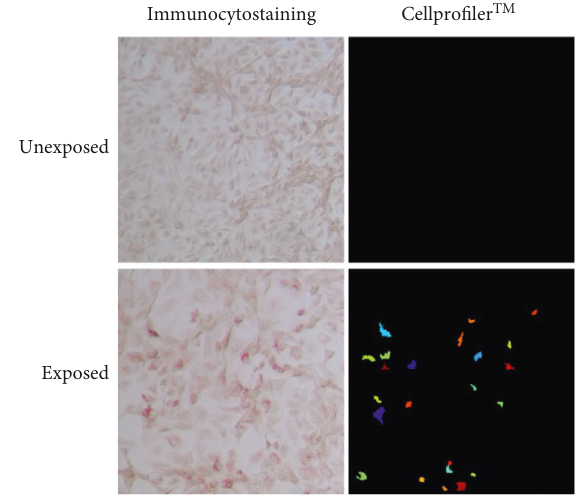
Figure 6: FFAs of natural DENV infection. 10x magnification factor. The plasma was diluted 4 times. The different foci detected automatically by the free software CellProfiler ™ are marked by color, and the threshold used to detect the foci was determined based on the unexposed foci. Representative images of three sera tested in duplicate are shown.